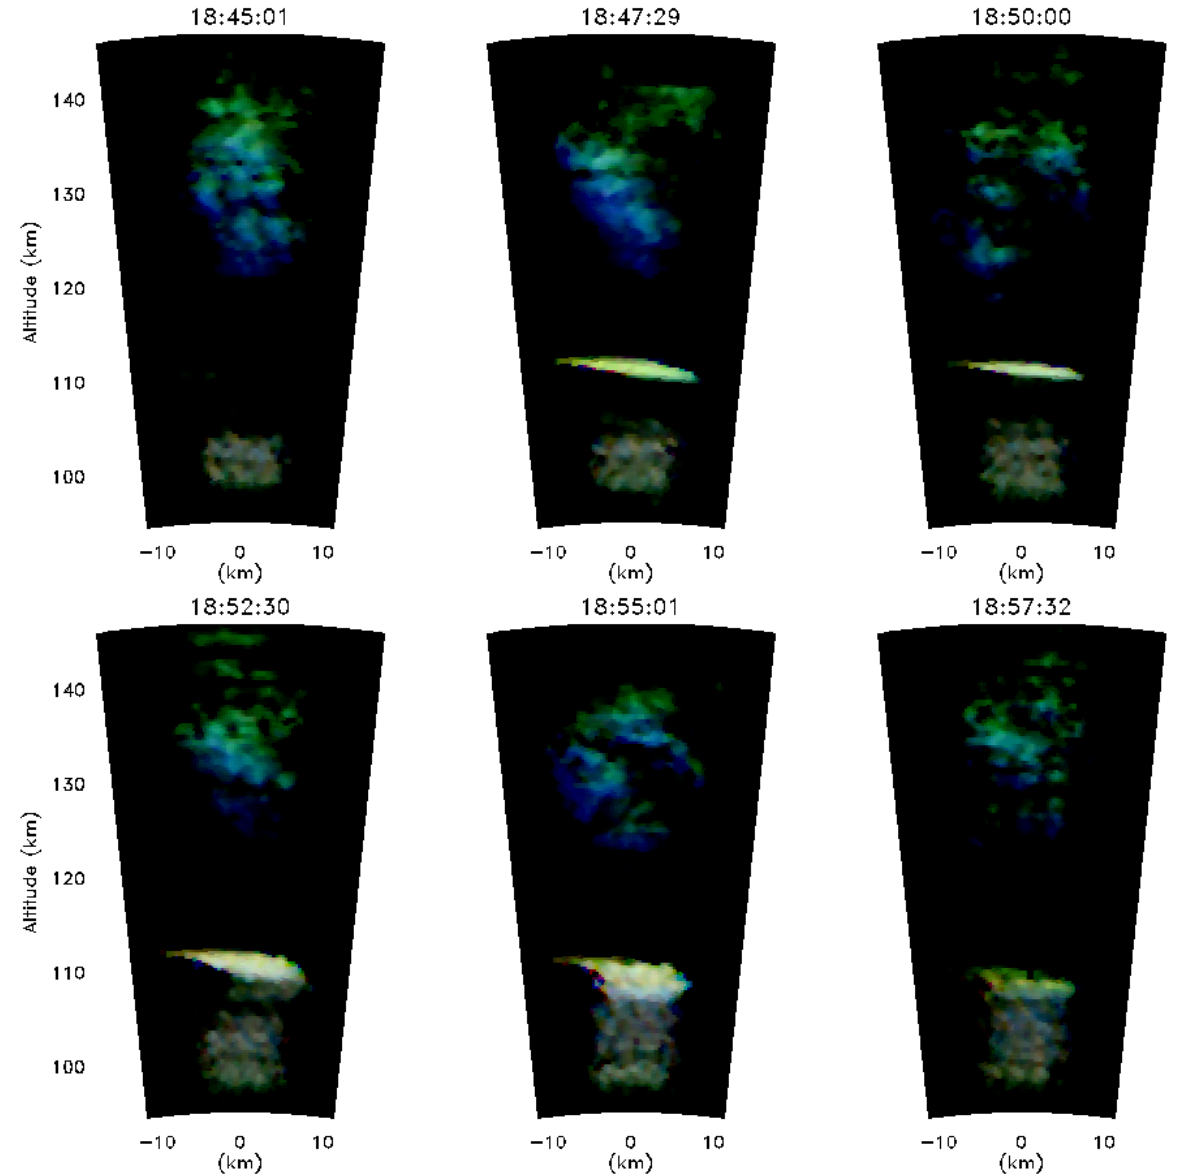
Fig. 4. Aperture synthesis images of high-altitude EEJ echoes observed around twilight on 19 November 2003 at six different local times. The vertical and horizontal axes of each snapshot represent the altitude and East-West (West to the left) distance in kilometers.